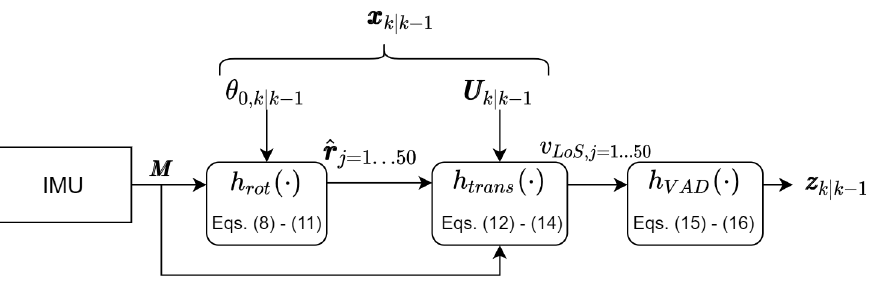
Figure 5. Block diagram depicting the measurement function h ( . ) , as a chain process in which rotation, translation, and VAD retrieval are modelled as elementary functions. Equation numbers inside each block refer to pertinent equations in the